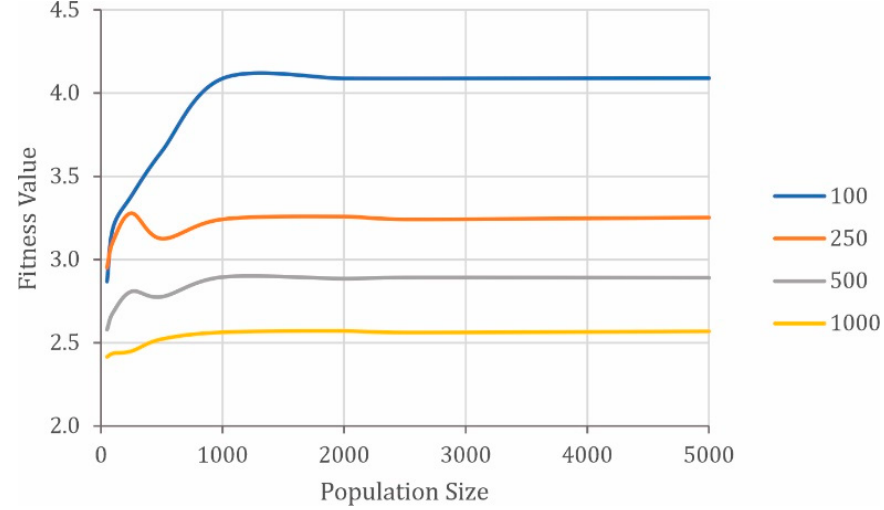
Figure 3. GA performance.